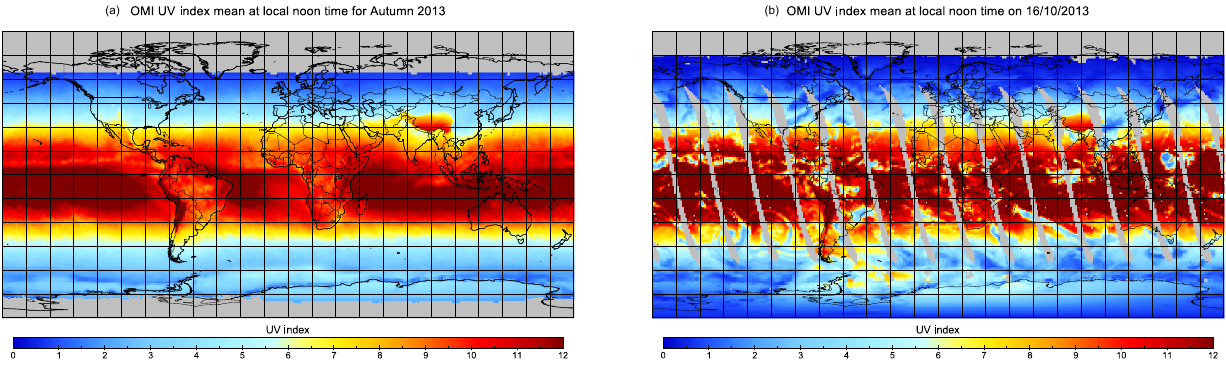
Figure 14. (a) Three-month mean UV index from OMUVB in the boreal fall season 2013 (September–November). (b) Global map of daily UV index on 16 October 2013 showing exceptionally high UV index values in Patagonia due to the stretched ozone